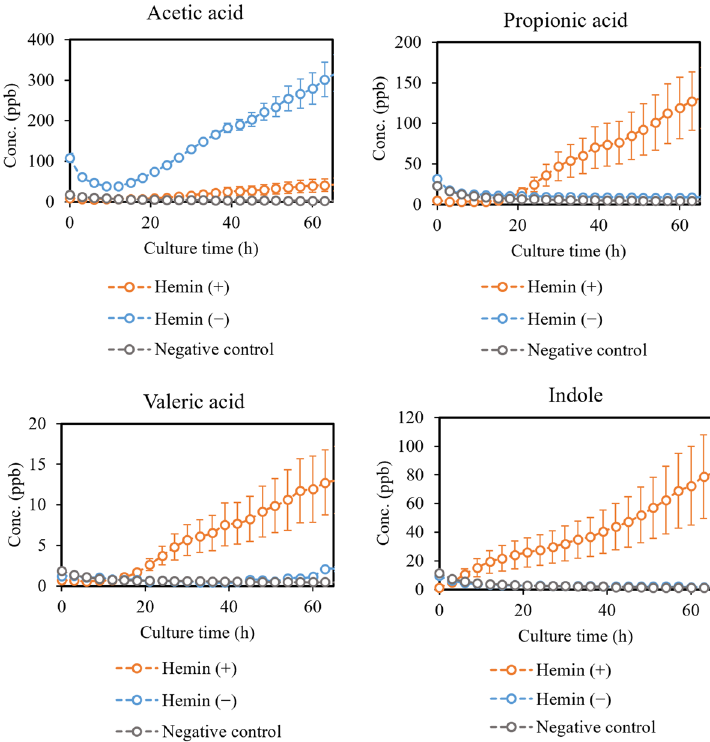
Figure 5. Compounds produced in increased (acetic acid) and decreased (propionic acid, valeric acid and indole) amounts by P. gingivalis cultures with ( +) and without ( −) supplemental hemin added. Concentrations are given as the mean ± SD of triplicate measurements (N =